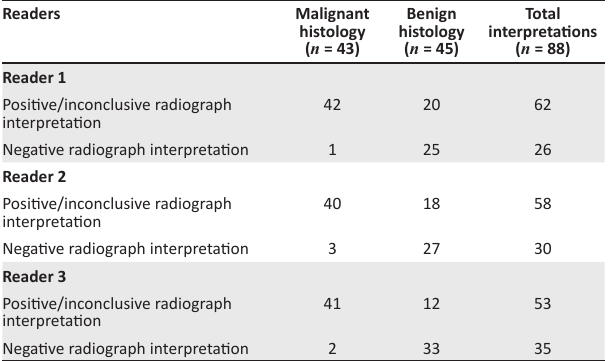
TABLE 3: Sensitivity and specificity for the interpretation of readers 1, 2 and 3.